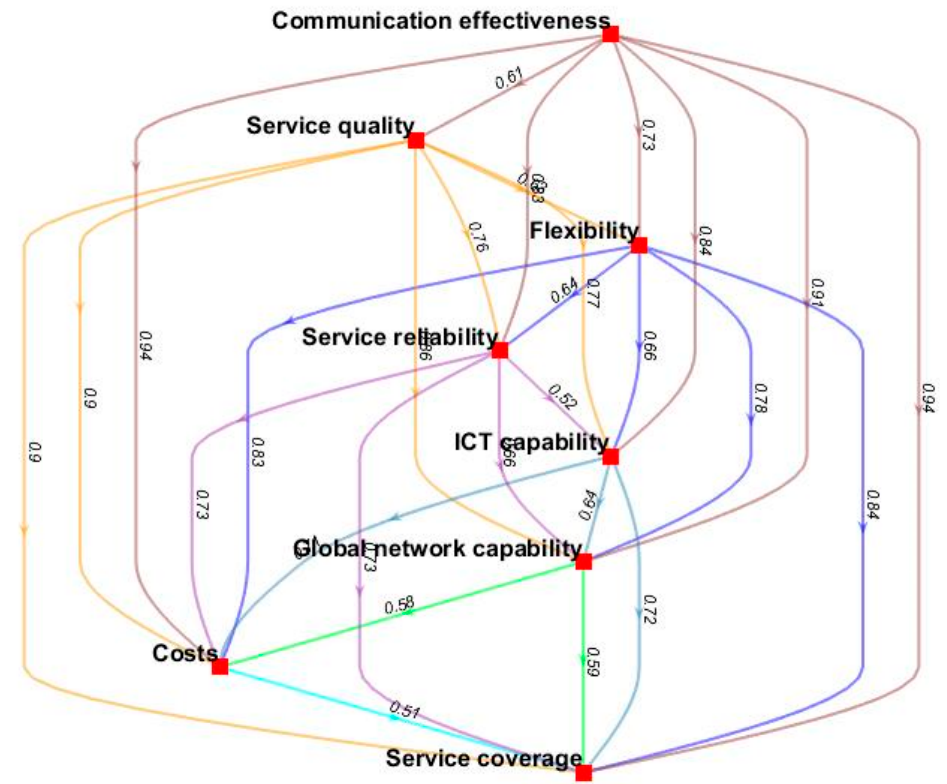
Figure 9. Graphical illustration of the credal ranking of the eight criteria in the 3PL selection problem. Table 6. Aggregated result summary of the 3PL selection problem.